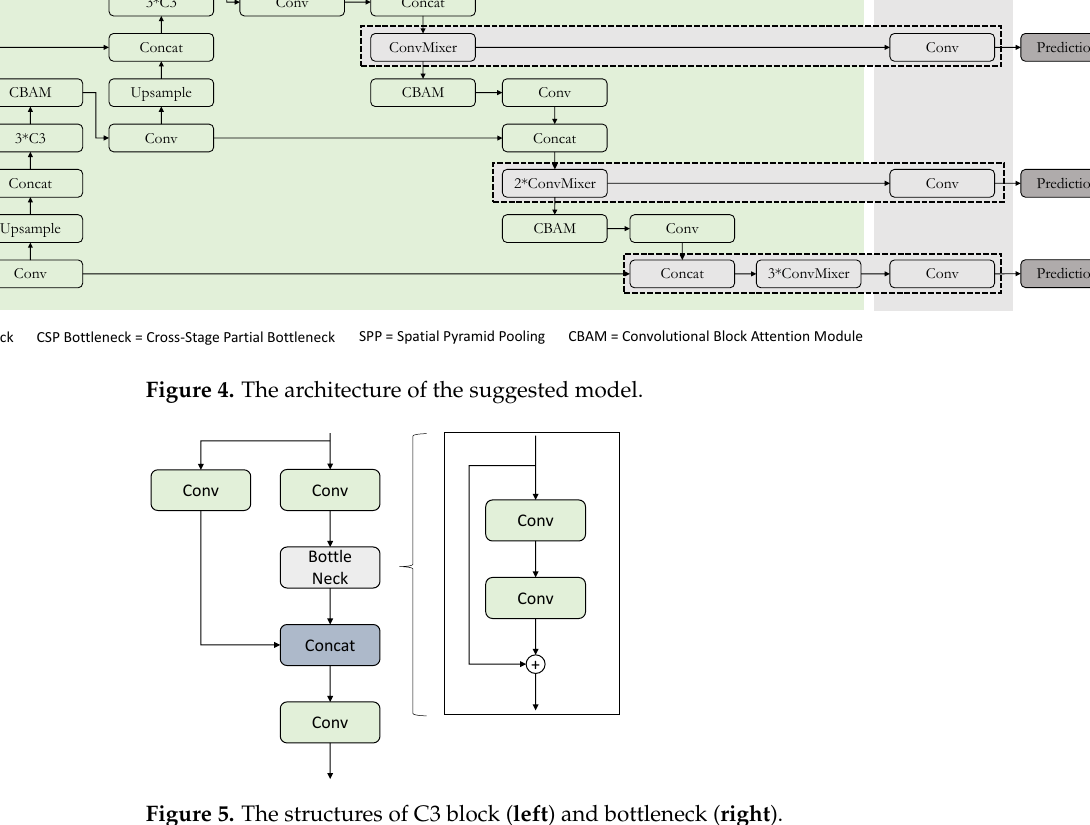
Figure 5. The structures of C3 block ( left ) and bottleneck ( right